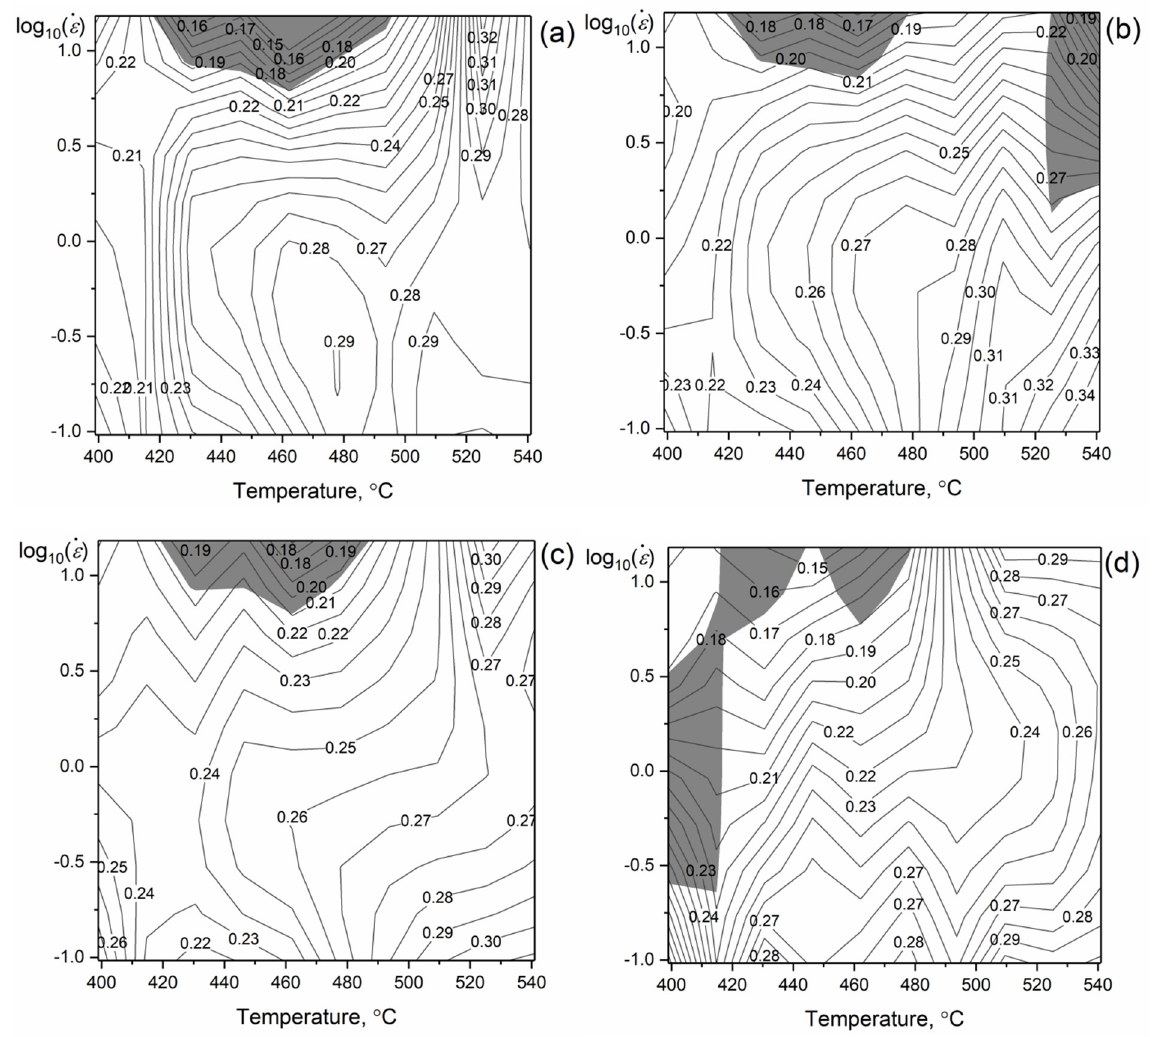
Figure 4. Processing maps of the investigated alloys: ( a ) AlCuYMg1, ( b ) AlCuErMg1, ( c ) AlCuYMg2, and ( d ) AlCuErMg2. Line contours are the values of the power dissipation efficiency ( η ), and the gray areas correspond to the negative values of the instability criteria.